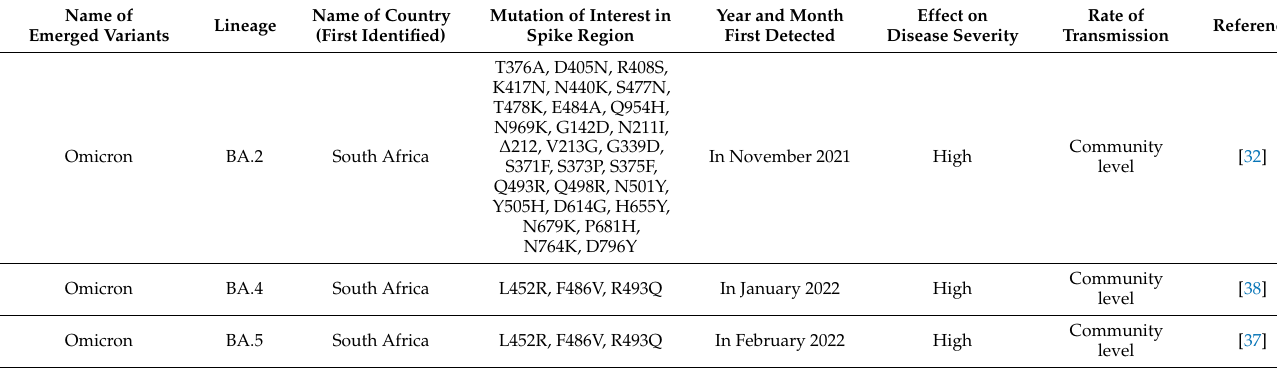
Table 3. Variants of